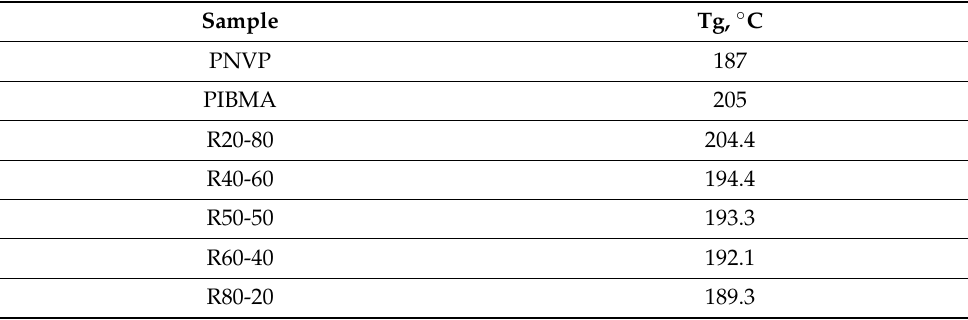
Table 6. Tg values of the statistical copolymers synthesized via